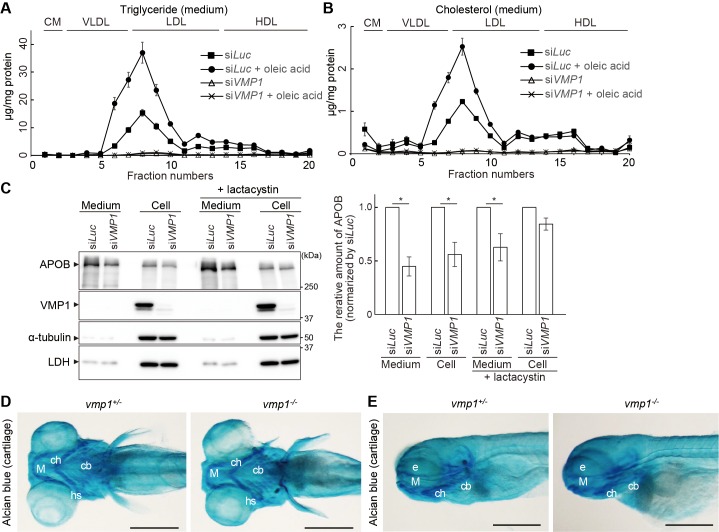
VMP1 is required for secretion and homeostasis of lipoproteins but not for formation of cartilage structures in the zebrafish head skeleton.(A and B) HepG2 cells were treated with siRNA against luciferase (Luc) or VMP1 and cultured in 0.1% bovine serum albumin (BSA) containing media with or without 200 μM oleic acid for 2 days. Triglycerides- (A) and cholesterols-containing lipoproteins (B) in medium were fractionated by chromatography and analyzed. CM, chylomicron; VLDL, very-low-density lipoprotein; LDL, low-density lipoprotein; HDL, high-density lipoprotein. Data represent the mean ± standard error of the mean (n = 3). (C) HepG2 cells were treated as in (A) and cultured in serum-free medium containing 200 nM oleic acid in the presence or absence of 5 μM lactacystin for 24 hr. The medium was concentrated by TCA precipitation. Samples (approximately 7% or 14% vol of total precipitated media or cell lysates, respectively) were subjected to immunoblot analysis. The amount of APOB was quantified through densitometric scanning of bnd intensities. Data represent the mean ± standard error of the mean (n = 4), which was normalized to siLuc, and statistically analyzed using the Student’s t-test (*, p<0.05). (D and E) Dorsal (D) and lateral (E) views of the head skeleton of 6-dpf vmp1+/- and vmp1-/- zebrafish stained with Alcian blue. M, Meckel’s cartilage; ch, ceratohyal cartilage; cb, ceratobranchial cartilage; e, eye; hs, hyosymplectic cartilage. Scale bars, 500 μm.10.7554/eLife.48834.011Figure 4—figure supplement 1—source data 1.Related to Figure 4—figure supplement 1A–C.